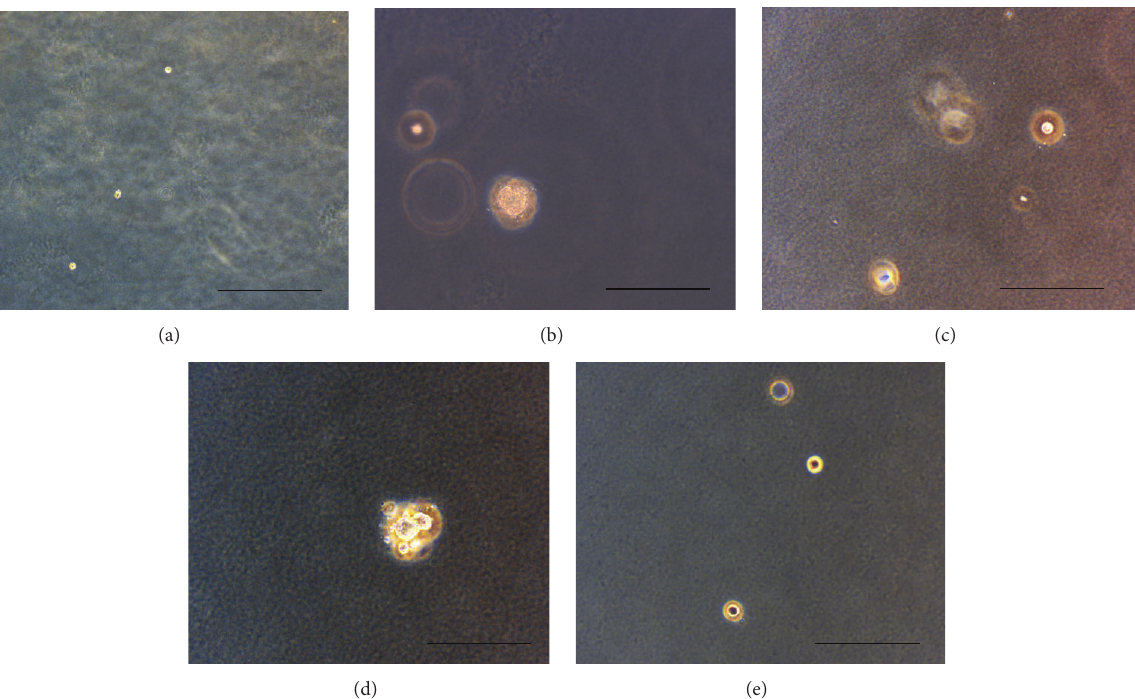
Figure 11: Soft agar assay on OSA3, OSA3-CSCs, Saos-2, and PA. After 24 h from the setup of the assay cells appear isolated into the agar (a). Observation in phase contrast. Original magnification 10x. While after 4 weeks spherical large colonies in OSA3-CSCs and in Saos-2 (b and d) were formed into the agar, they are absent for OSA3 (c) and PA (e). Observation in phase contrast. Original magnification 20x. Bar size: 100 𝜇 m.